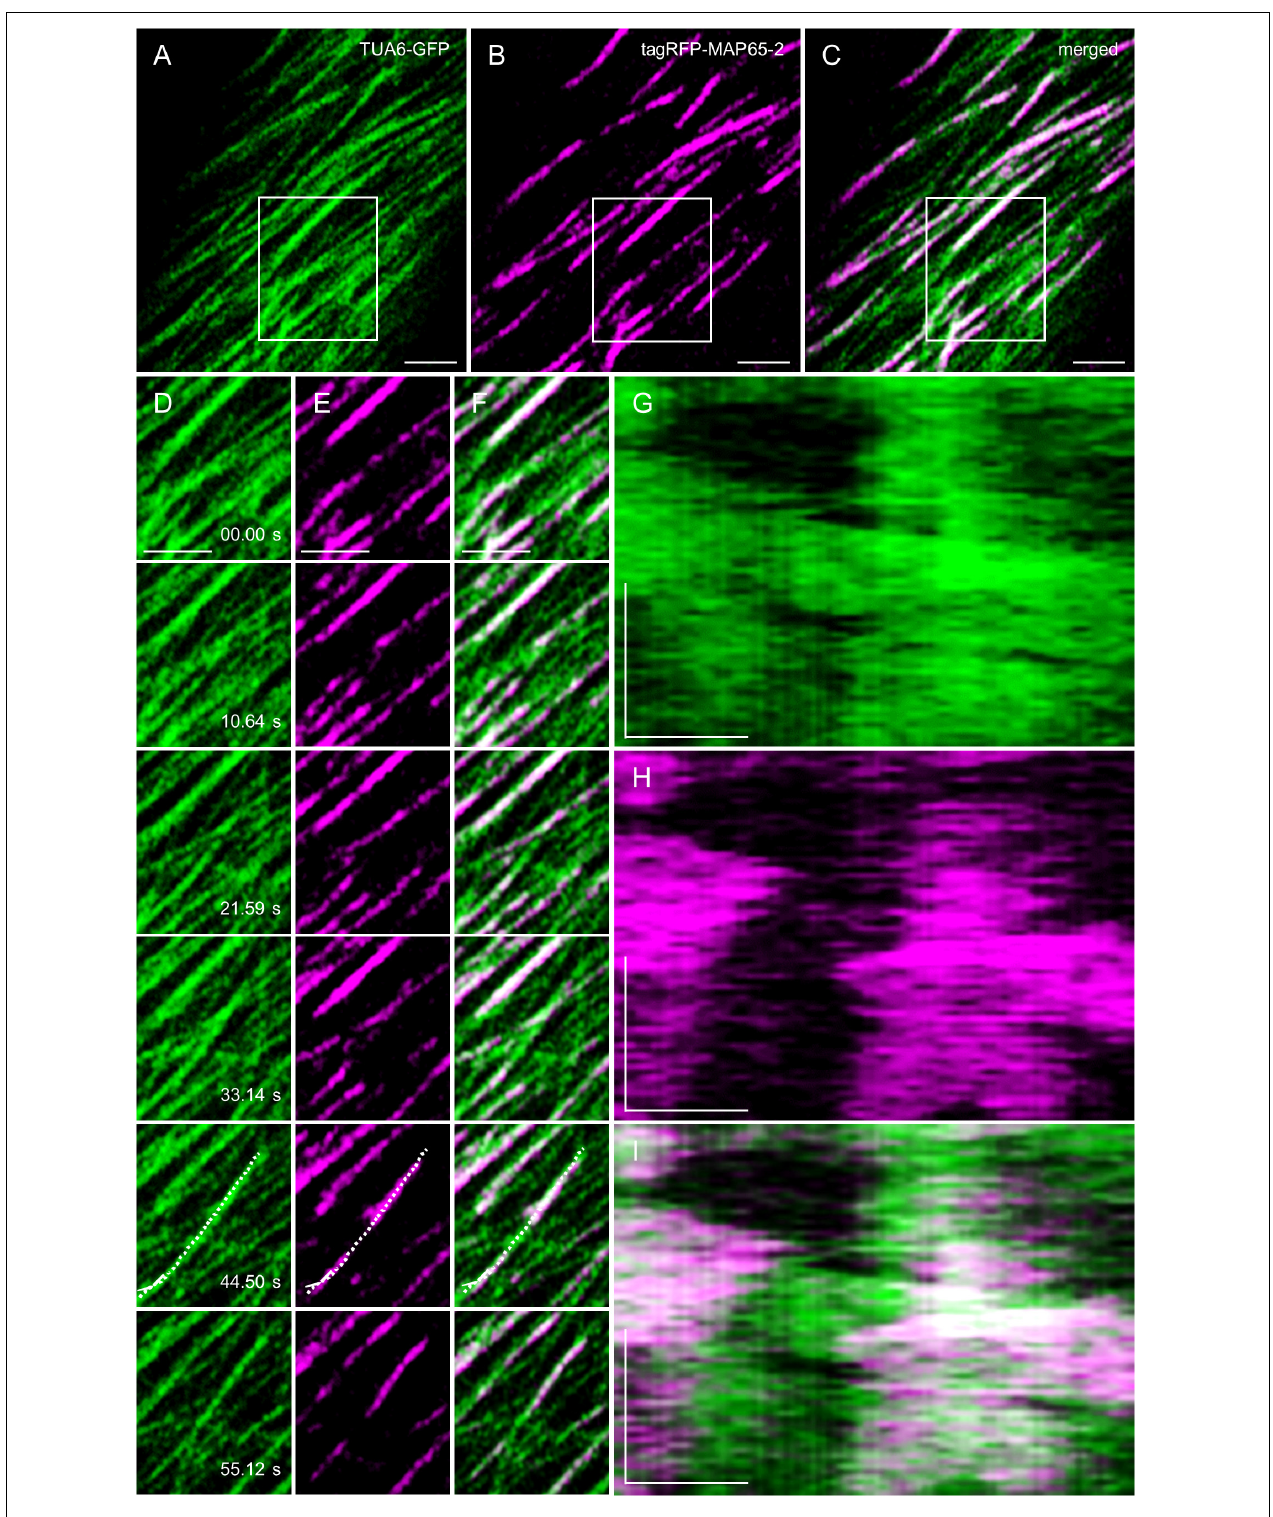
FIGURE 7 | MAP65-2 and microtubule dynamics visualized by ACLSM (see also Supplementary Video S1 ). (A–C) Is an overview of a hypocotyl epidermal cell of stably transformed line expressing both TUA6-GFP (A) and tagRFP-MAP65-2 (B) observed by ACLSM (objective 63 × /1.4 NA); in (C) is merged picture. Area in boxes is shown in stills (D–F) , within which is the region of interest where kymographs were generated (G–I) . Stills in (D) show TUA6-GFP, in (E) show tagRFP-MAP65-2 and in (F) are stills from merged picture. In (G) , kymograph is shown for TUA6-GFP, in (H) for tagRFP-MAP65-2 and in (I) for merged picture. Scale bars = 2 µ m (A–F) , 1 µ m (G–I) . Time bars = 1 min (G–I) .